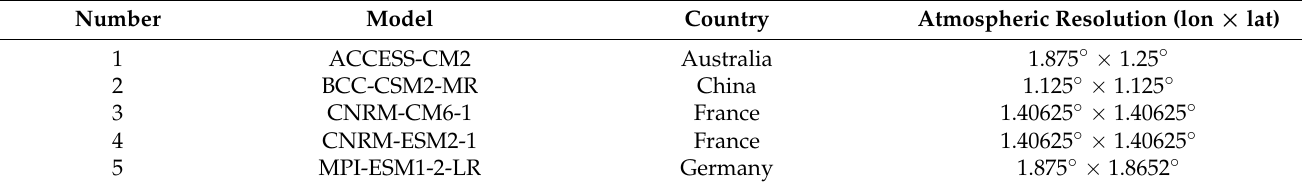
Table 2. Detailed information on the five CMIP6 climate models. The “lon” means longitude, the “lat” means latitude, and the “lon × lat” means the spatial resolution of each